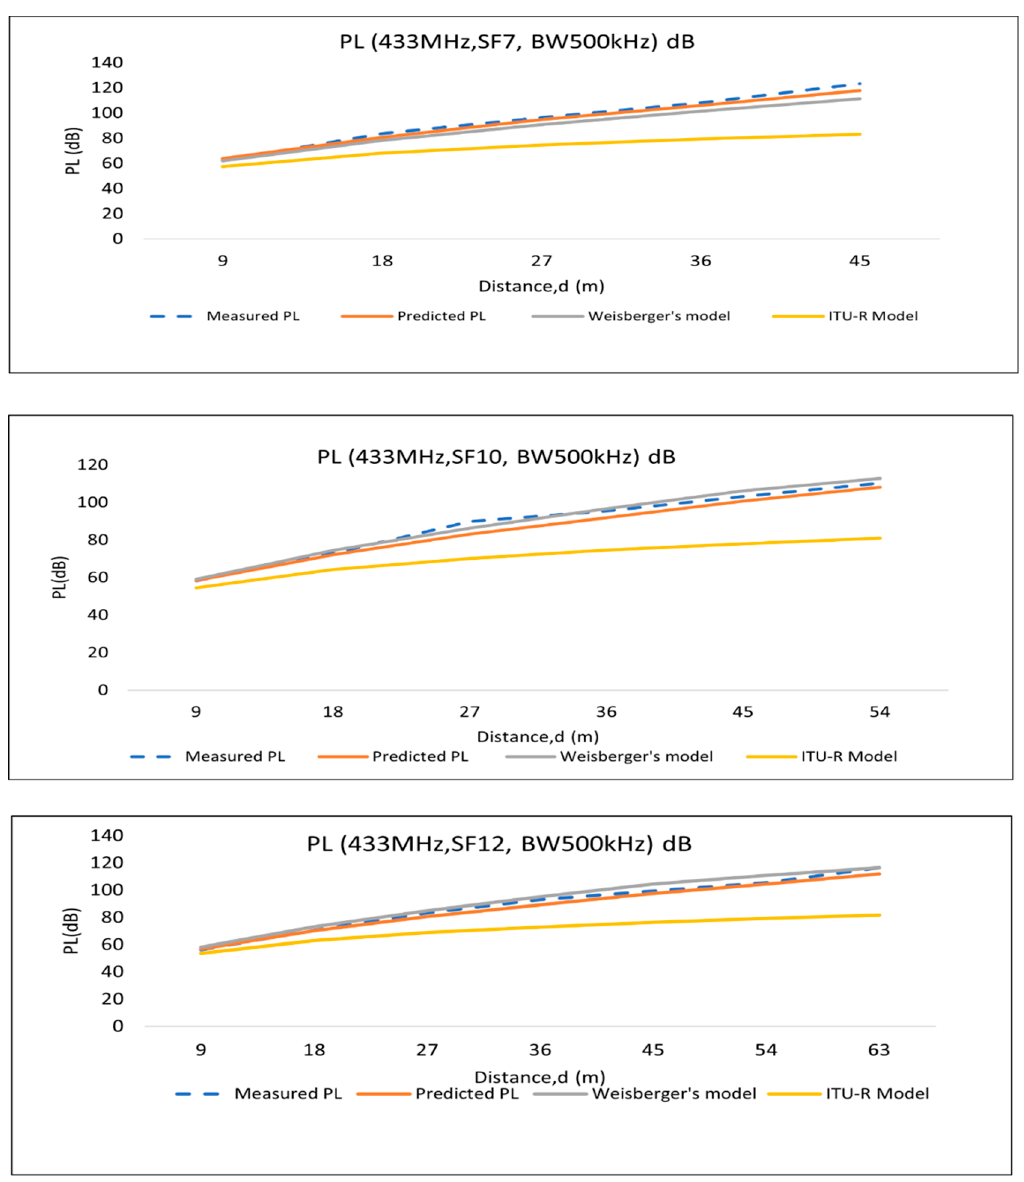
Figure 10. Path-loss comparison of 500 kHz bandwidth LoRa